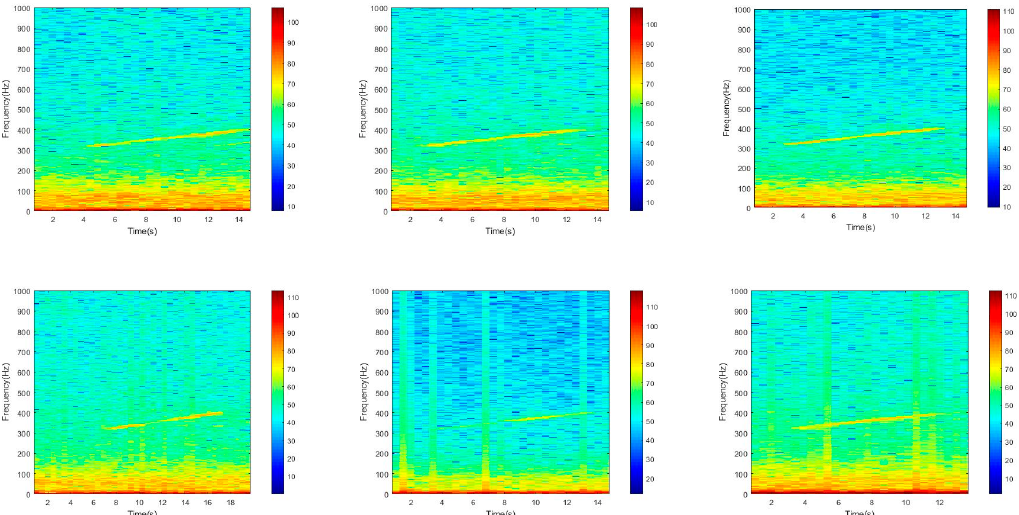
taset. Some of the data in the dataset are shown in Figure 21.